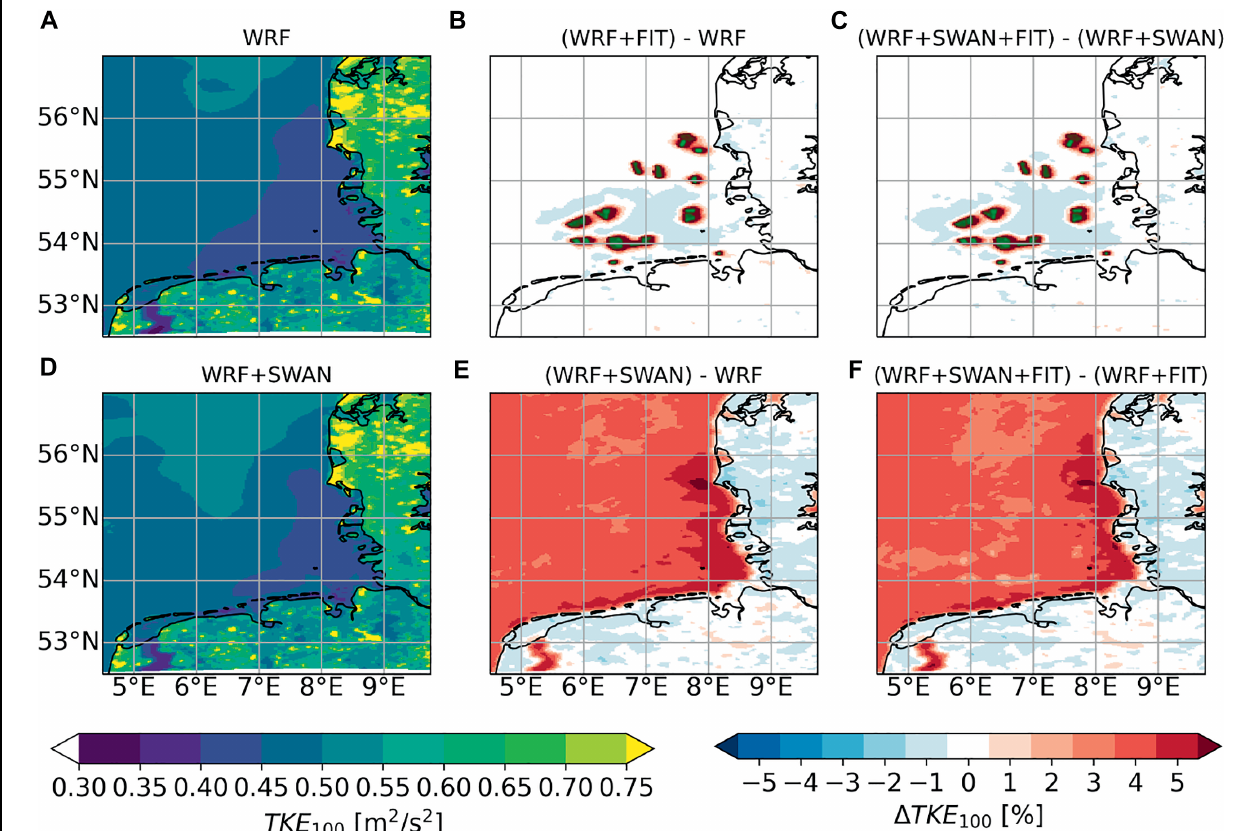
FIGURE 10 | (A,D) Simulated long-term TKE at 100 m height for (A) WRF and (D) WRF + SWAN and (B,C,E,F) relative reduction of wind speed based on (B) (WRF + FIT)-WRF, (C) (WRF + SWAN + FIT)-(WRF + SWAN), (E) (WRF + SWAN)-(WRF) and (F) (WRF + SWAN + FIT)-(WRF + FIT) all normalized by the respective